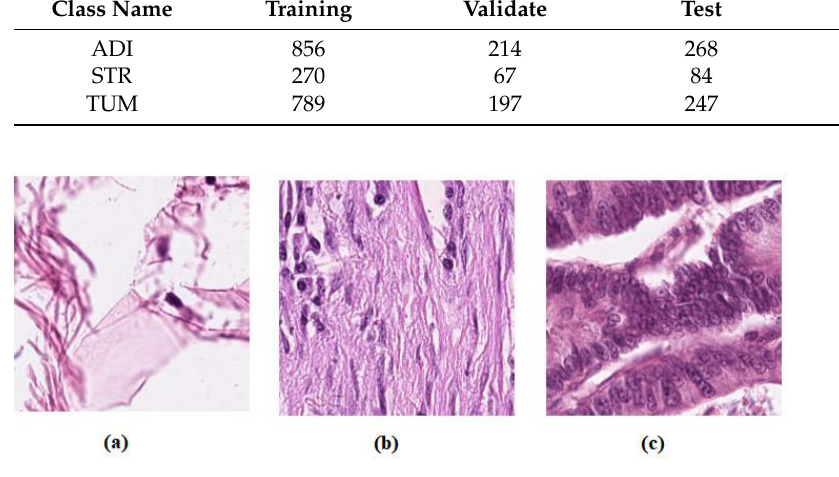
Figure 2. Example images from colorectal cancer test set: ( a ) ADI, ( b ) STR, and ( c )